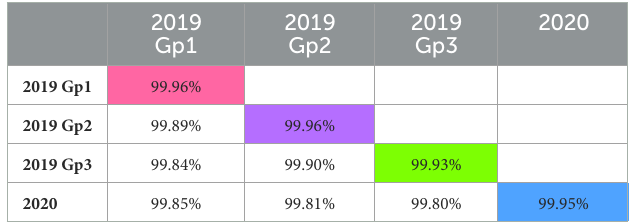
TABLE 1 Between- and within-group percent similarity among groups identified on phylogenetic